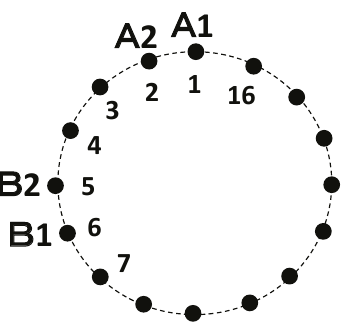
Figure 5 . An example of the setup for our lattice model. We set N = 16 and took j A j = j B j = 2. The distance d between A and B is d = 3. The complement of A and B , called C , consists of twelve lattice